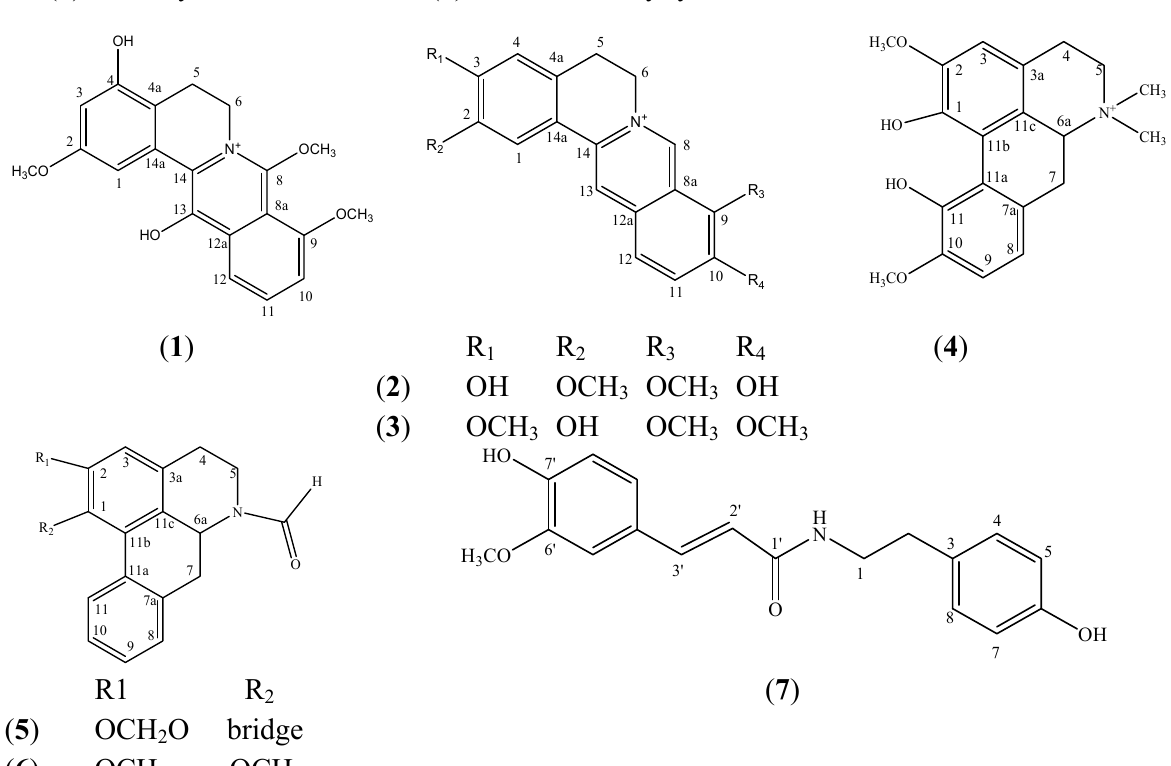
Figure 1. ( 1 ) 4,13-Dihydroxy-2,8,9-trimethoxydibenzo[a,g]quinolizinium; ( 2 ) dihydro- discretamine; N –formylannonaine; ( 6 ) N -formylnornuciferine; and ( 7 ) N - trans